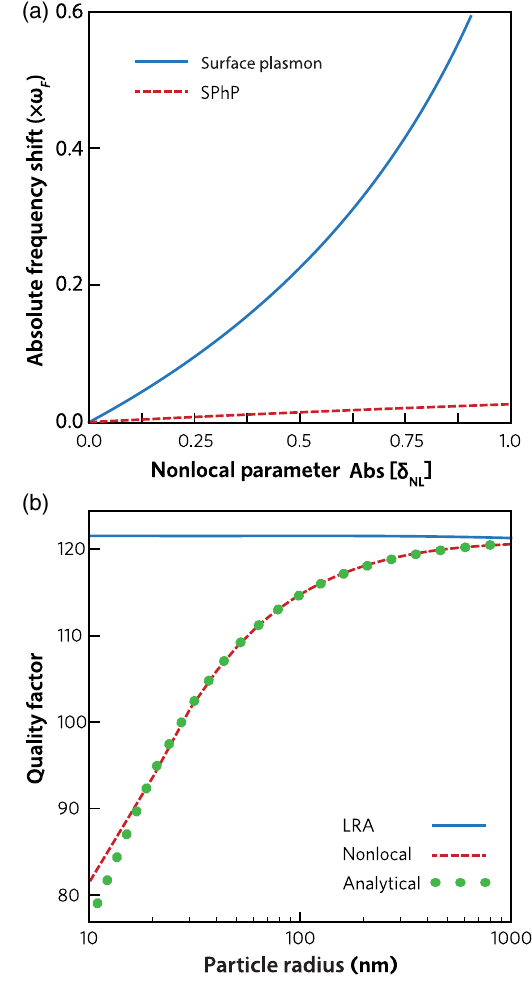
FIG. 3. (a) Absolute nonlocal frequency shift of the main Fröhlich peak in the extinction cross section as a function of the absolute value of the parameter quantifying the nonlocality. (b) Local and nonlocal quality factors forthe Fröhlich resonance of a 3C-SiC sphere, the dots represent the analytical model in Eq.